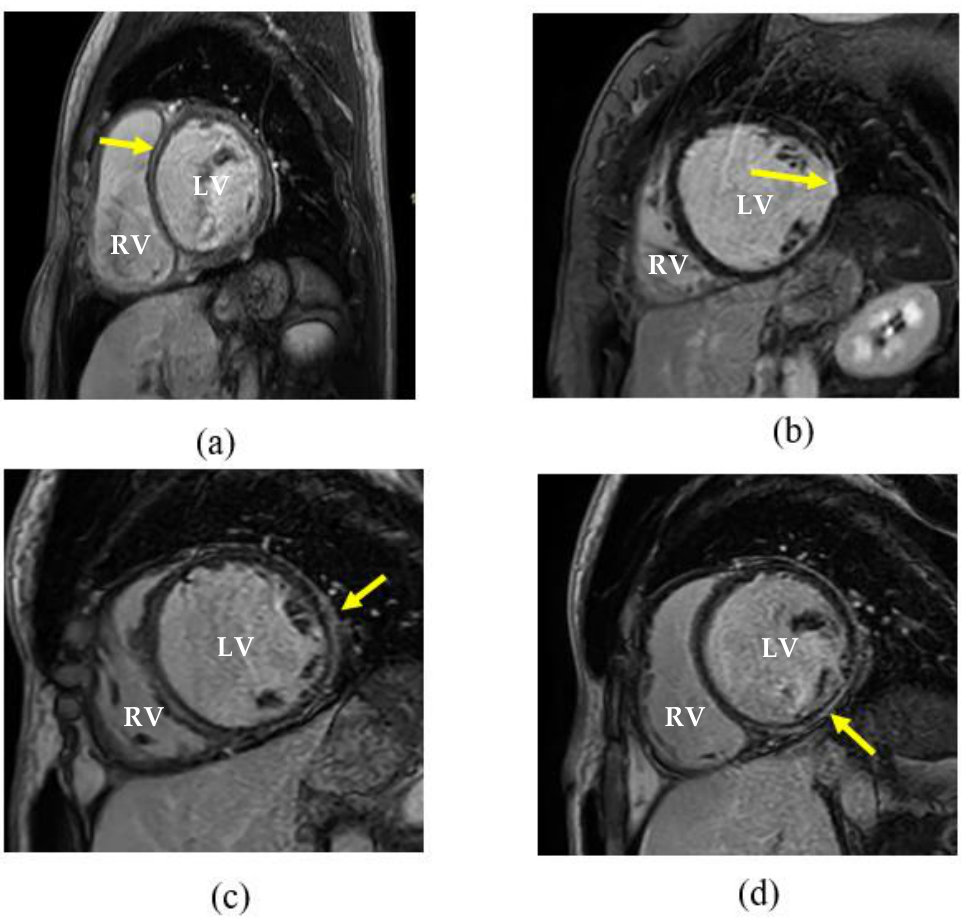
Figure 2. Late gadolinium enhancement cardiovascular magnetic resonance images showing the left and right ventricle. ( a ) Dilated cardiomyopathy with midwall enhancement of the septum (arrow); ( b ) subendocardial enhancement in the lateral ventricle free wall, typically associated with ischaemic heart disease; ( c ) shows an epicardial enhancement pattern in the lateral ventricle free wall and ( d ) inferior segment. LV = left ventricle; RV = right ventricle.